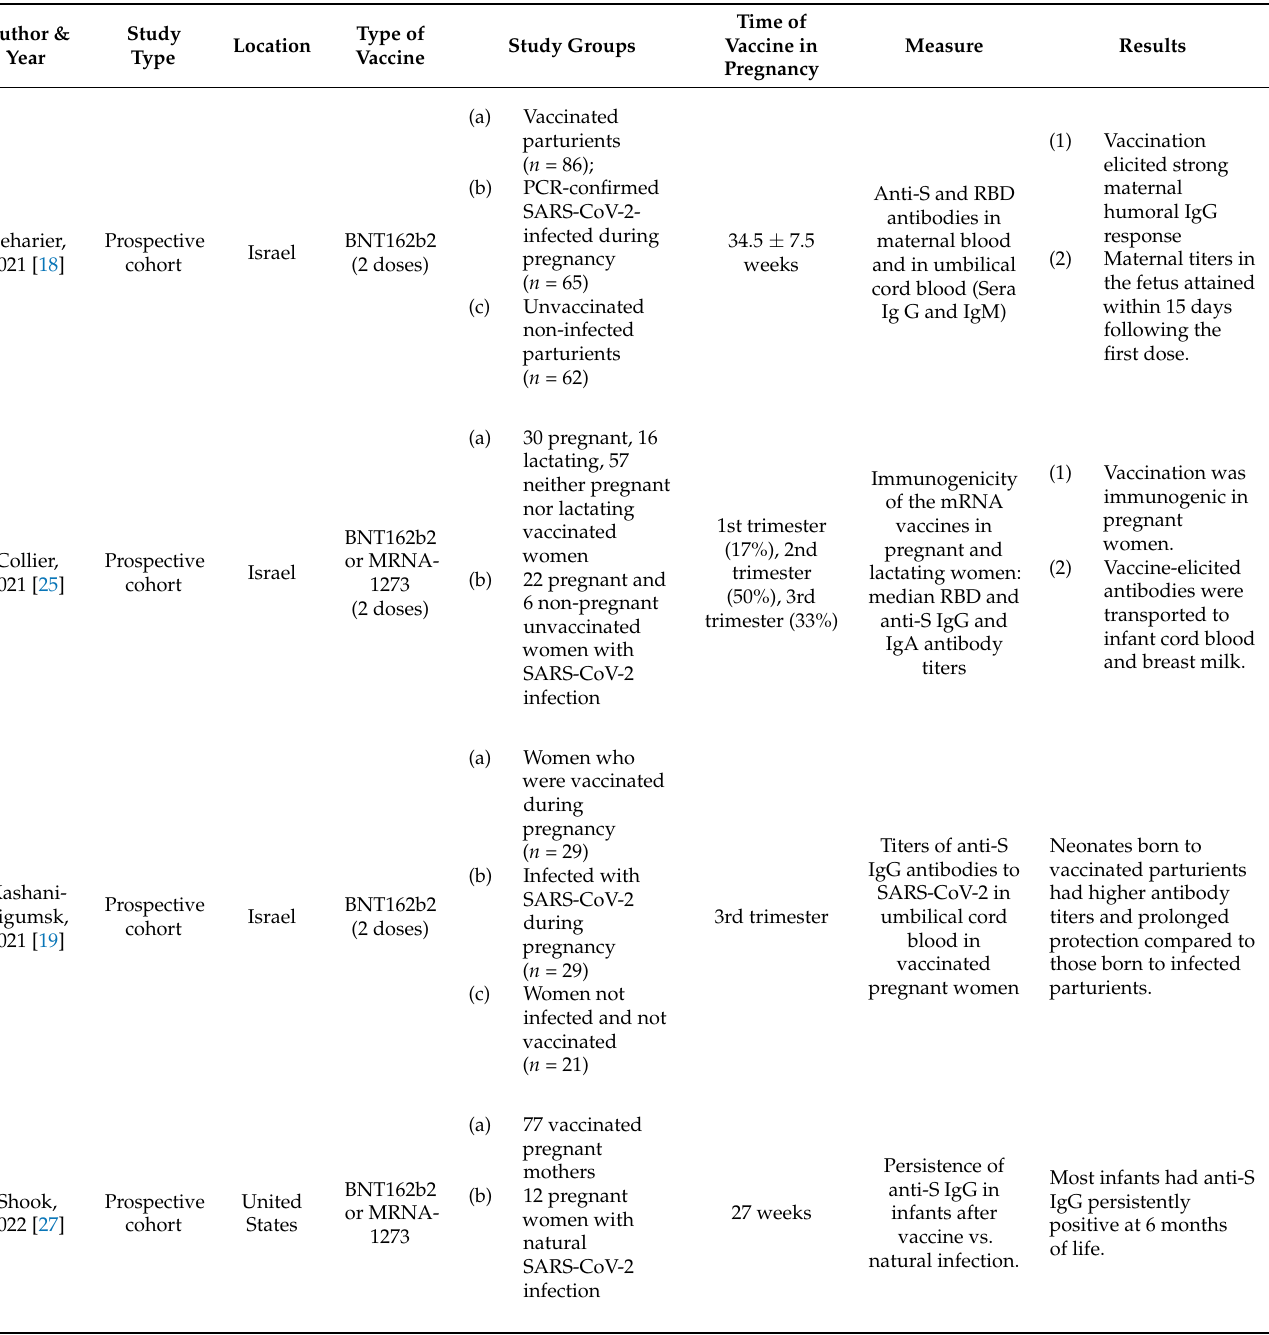
Table 1. Summary of studies showing the transplacental transfer of antibodies to newborns and early infants after maternal COVID-19